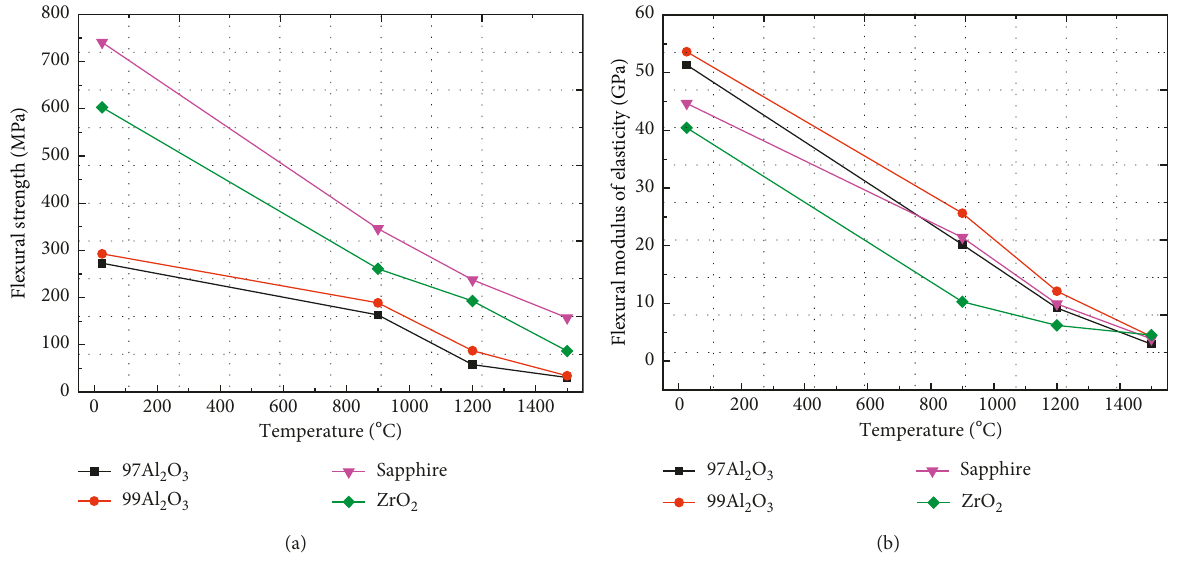
Figure 4: Flexural test result at different temperatures: (a) flexural strengths and (b) flexural moduli.